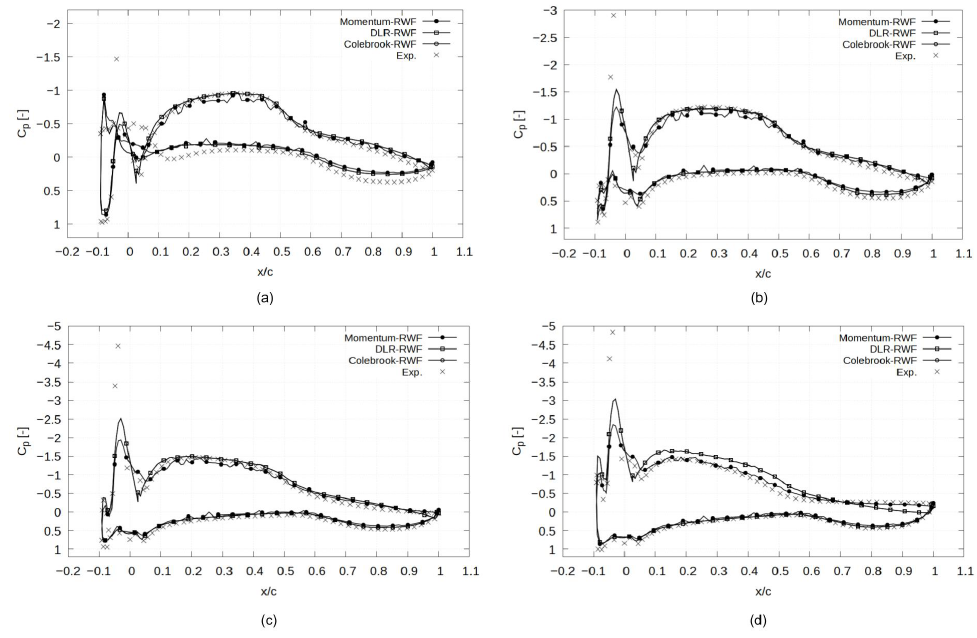
Figure 12. Case 2: C p distribution for AoA = ( a ) 0 ◦ , ( b ) 4 ◦ , ( c ) 8 ◦ , and ( d ) 12 ◦